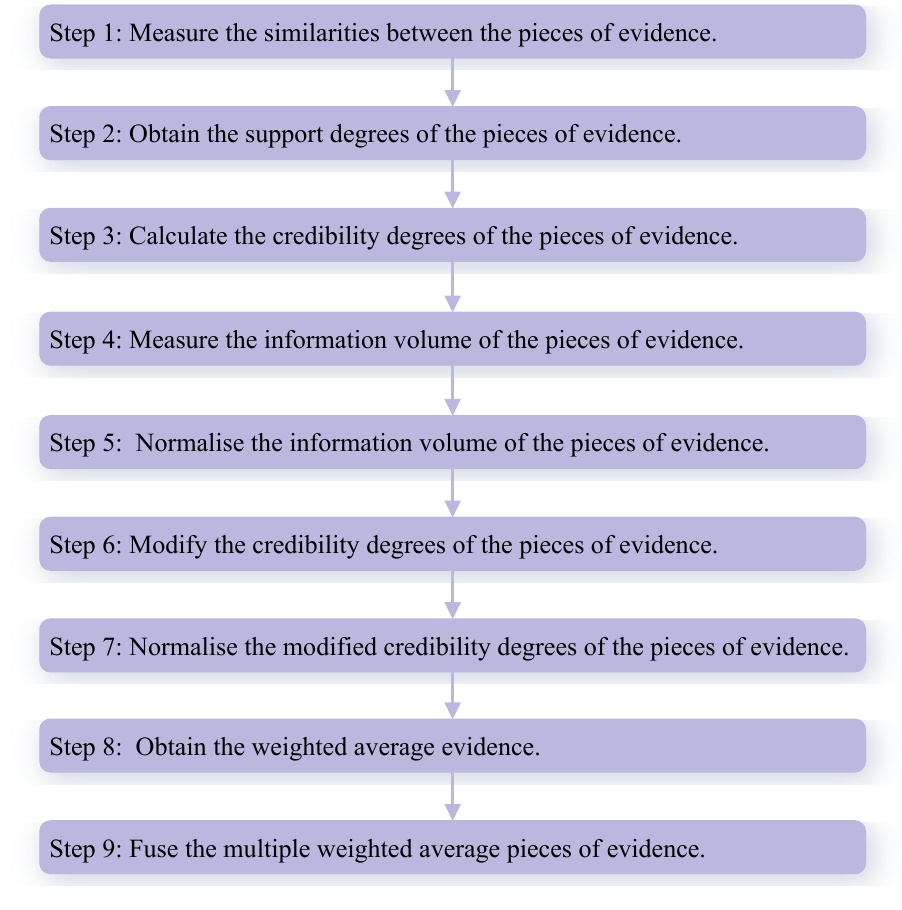
Figure 1. The flowchart of the proposed